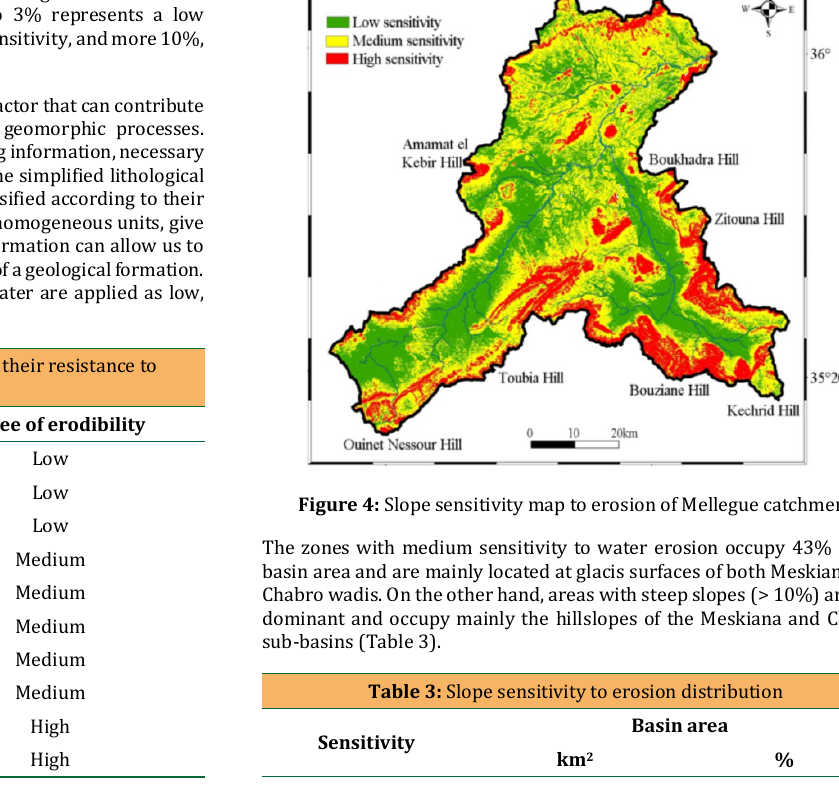
Flowchart presenting the steps of sensitivity mapping